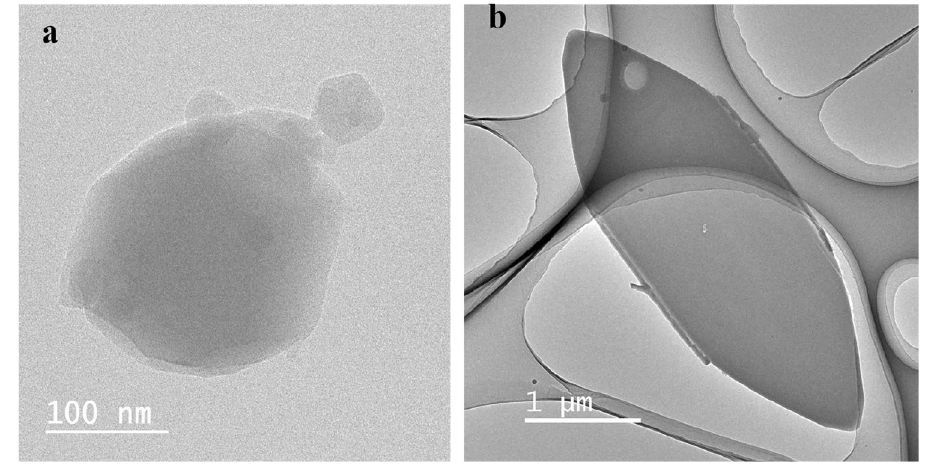
Figure 3. TEM images of ( a ) ZIF-8 and ( b )